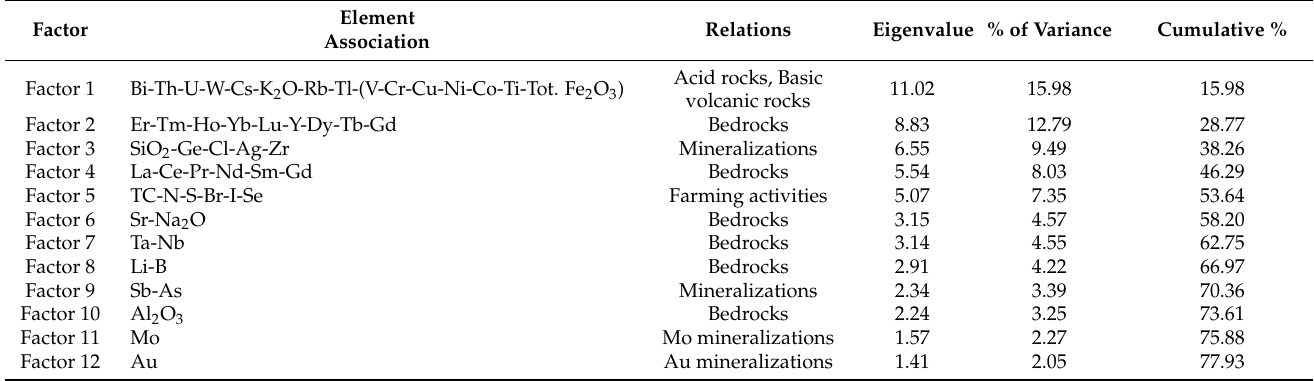
Table 5. Results of the factor analysis based on the clr-transformed data and the selected factors based on threshold of 0.6 (the absolute threshold